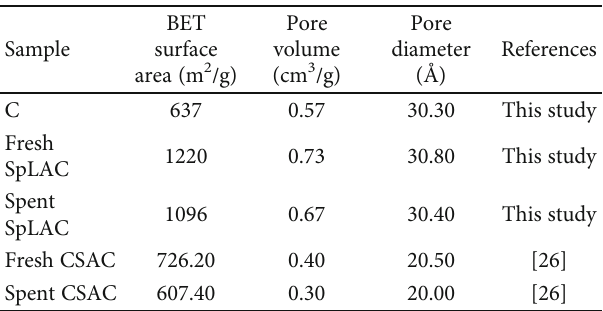
Table 4: Textural properties of activated fresh and activated spent